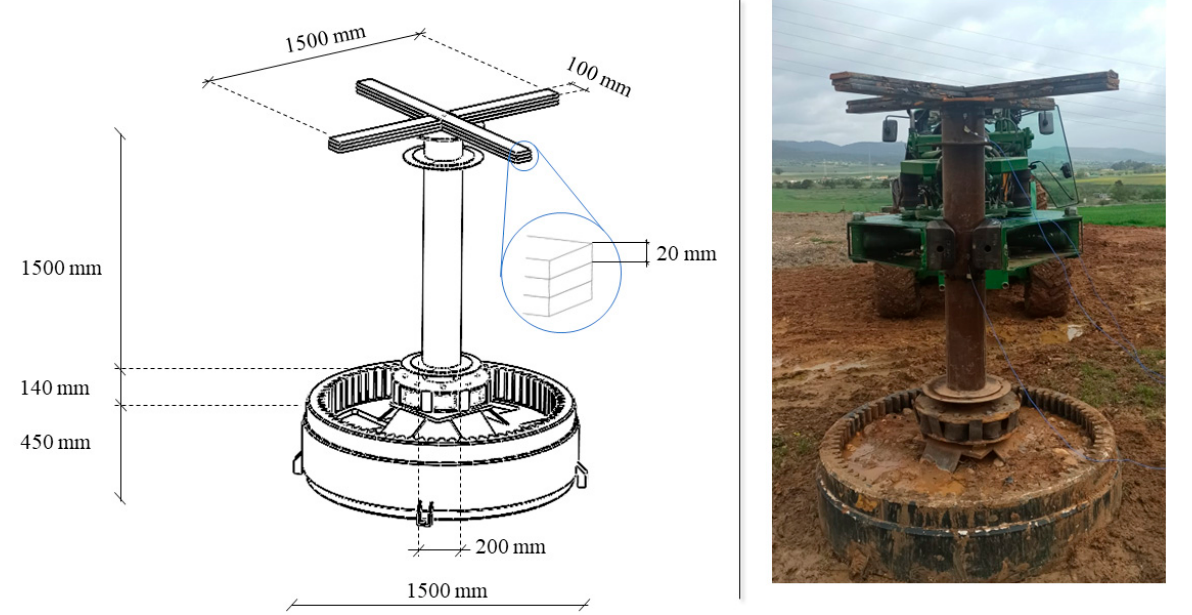
Figure 2. Test bench made together with the trunk shaker set up for the vibration test ( right ) and dimensions test bench ( left ).